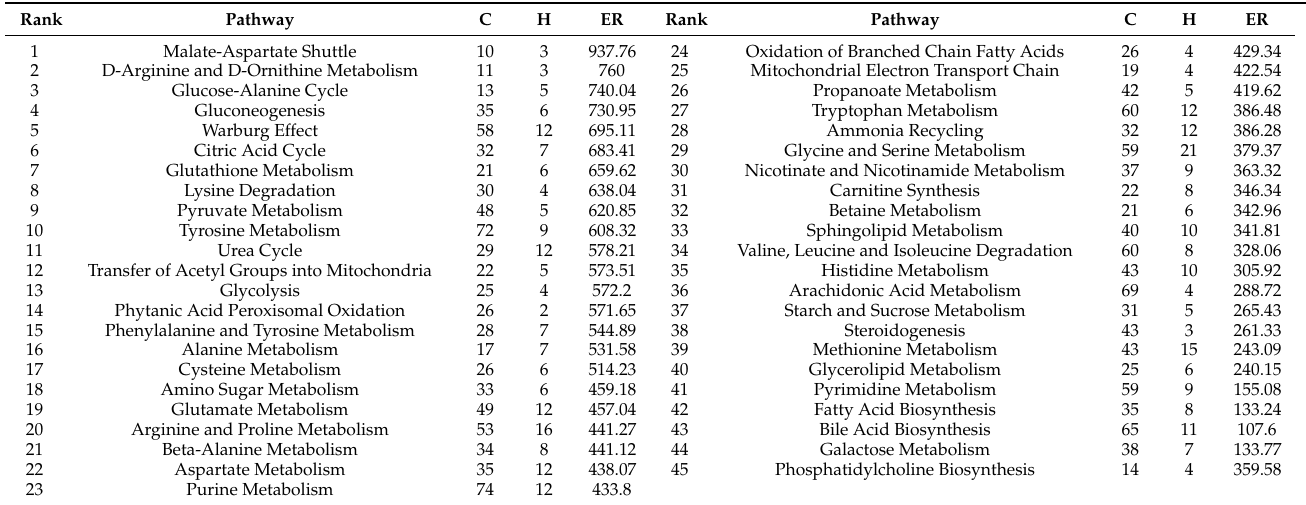
Table 1. The 45 most significant enriched pathways with FDR corrected p < 10 −3 00 .